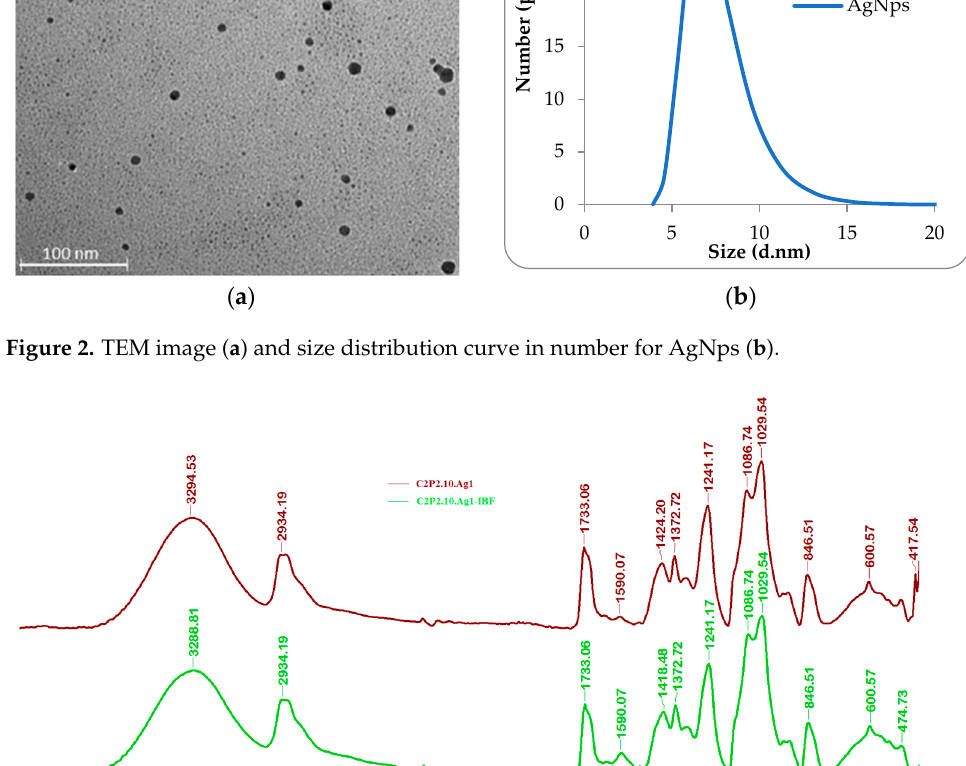
Figure 2. TEM image ( a ) and size distribution curve in number for AgNps ( b ) .